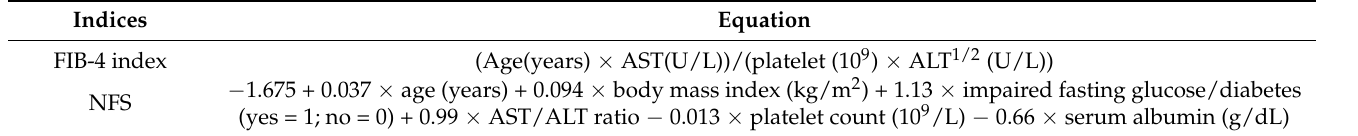
Table 1. The calculation of the FIB-4 index and